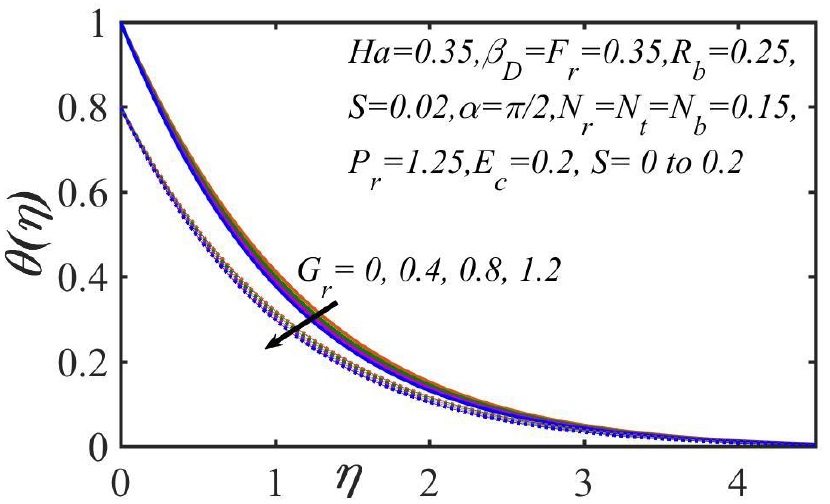
Figure 9. Effects of 𝐺 𝑟 and 𝑆 on temperature magnitude. Hard curve: 𝑆 = 0 ; dotted curve: 𝑆 = 0.2 .